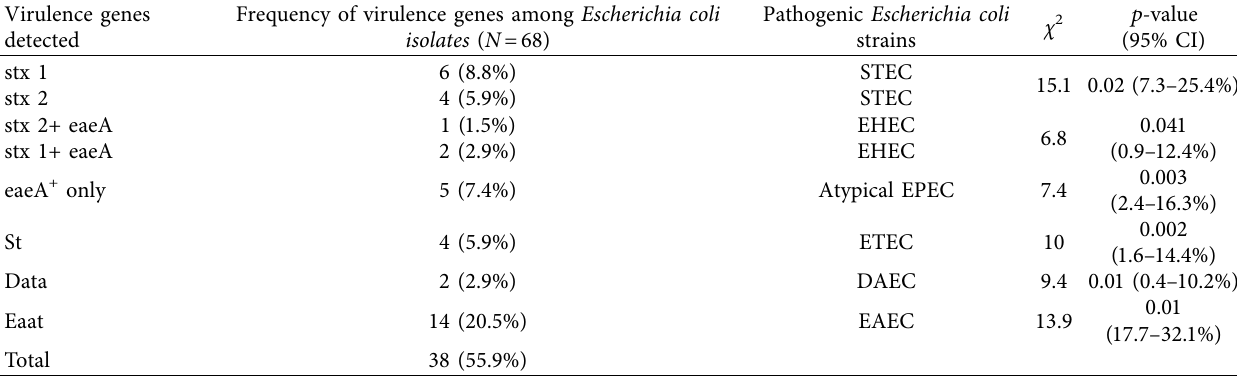
Table 2: Frequency of virulence genes and corresponding pathogenic Escherichia coli strains in diarrheic children. Virulence genes